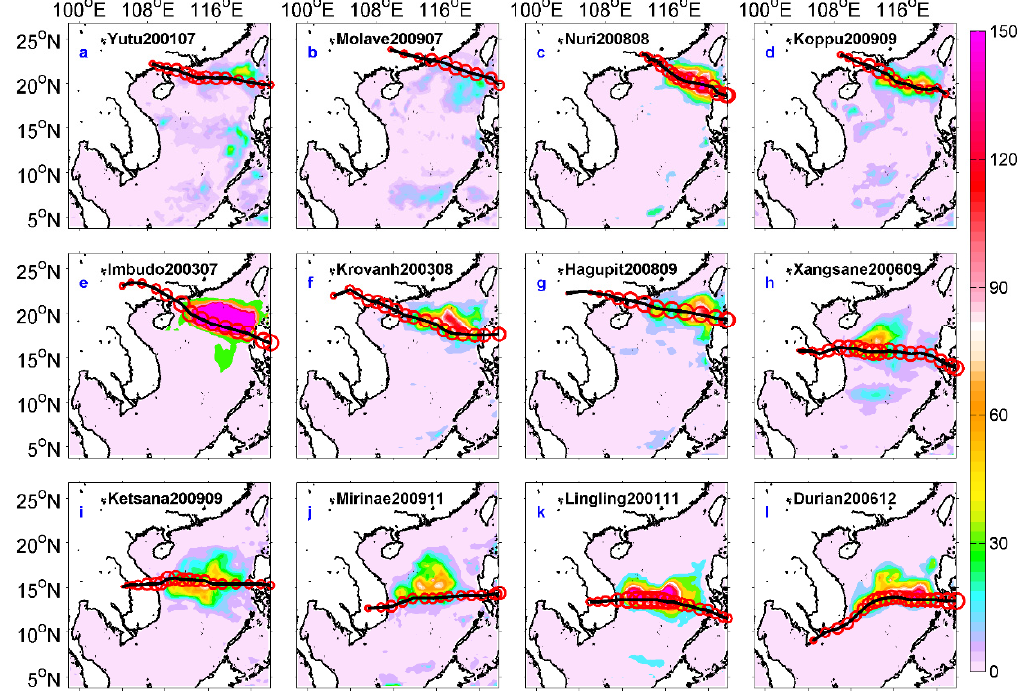
Figure 4. Typhoon tracks and surface 3-day averaged near-inertial kinetic energy (NIKE) (unit in J / m 3 ), filtered from the Hybrid Coordinate Ocean Model (HYCOM) reanalysis data when Typhoons Yutu ( a ), Molave ( b ), Nuri ( c ), Koppu ( d ), Imbudo ( e ), Krovanh ( f ), Hagupit ( g ), Xangsane ( h ), Ketsana ( i ), Mirinae ( j ), Lingling ( k ), and Durian ( l ) passed over the South China Sea (SCS). Here, and subsequently, the red circles indicate the position of the typhoon center every 6 hours, and the size of the circle indicates the magnitude of the typhoon speed.